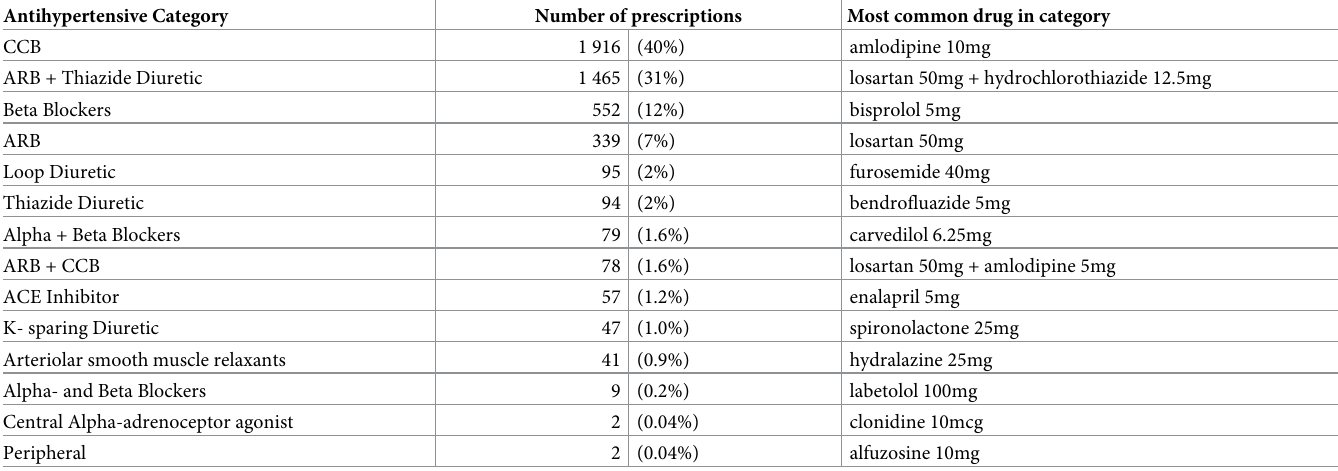
Table 3. Prescription